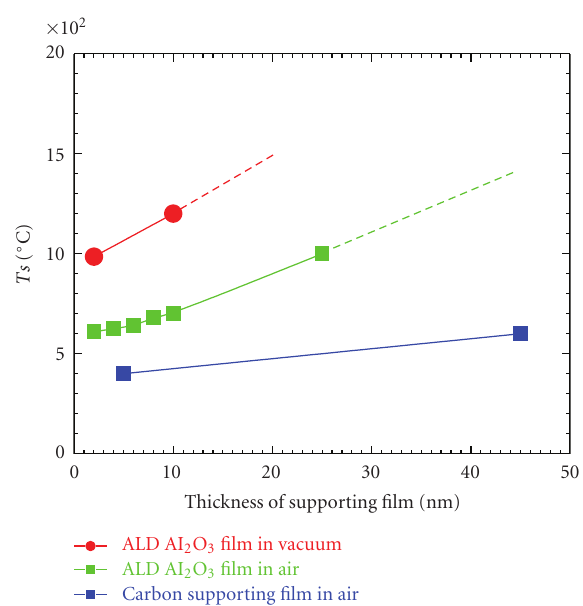
Figure 3: Mechanical stability dependence of thickness of ALD Al 2 O 3 films with data of carbon supporting films for comparison.